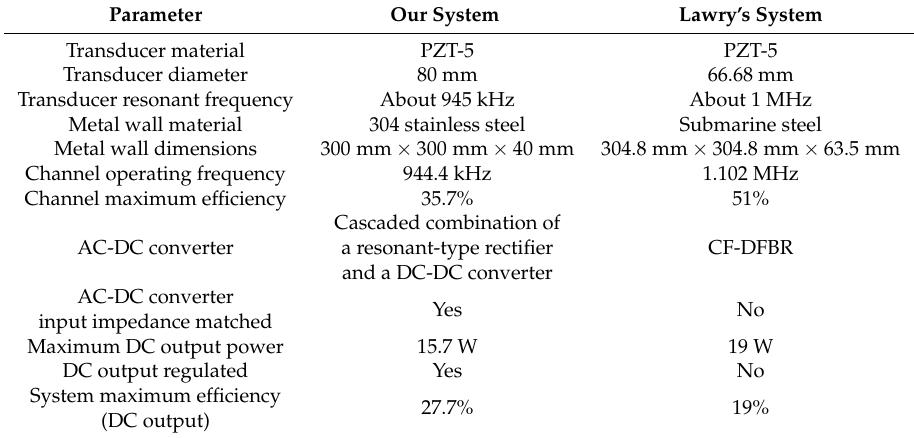
Table 3. Comparison between our system and the system presented by Lawry et al.